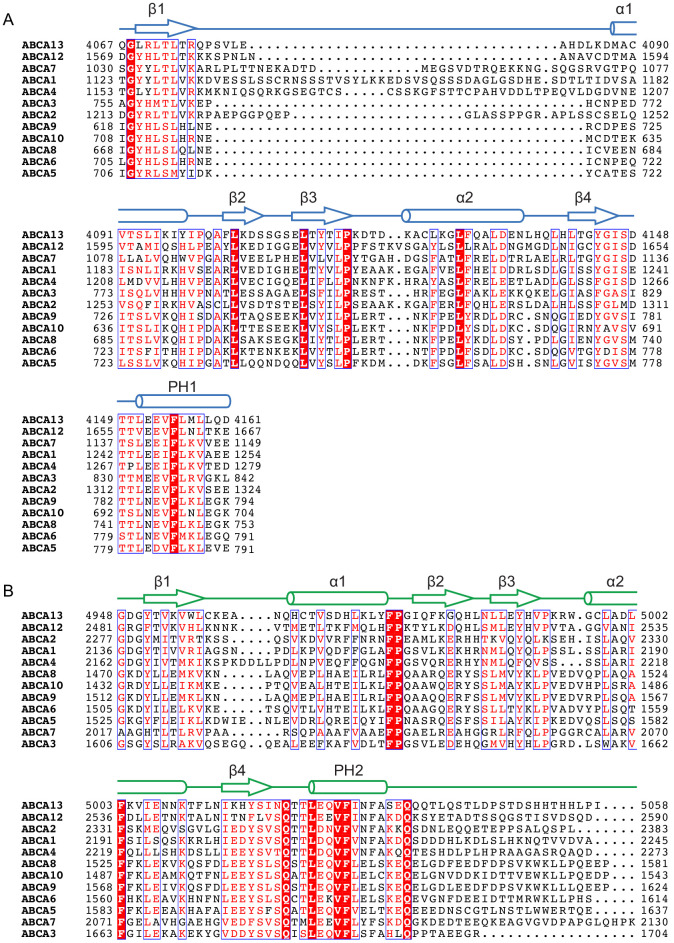
The ACT motifs and the pinning helices (PHs) are conserved in the ABCA subfamily.Sequence alignment and secondary structure prediction of (A) RD1 and (B) RD2, output of PROMALS3D (Pei et al., 2008). RD: regulatory domain.